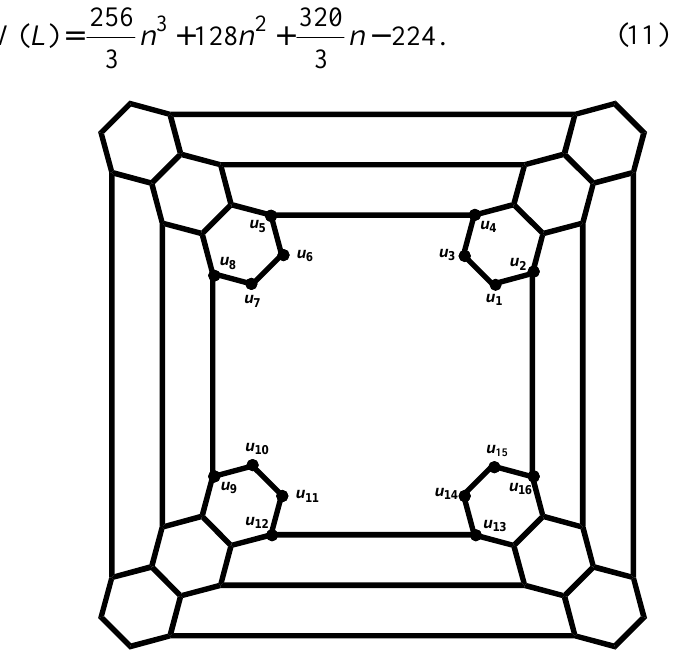
Figure 4. 2 - D graph of nanotube L